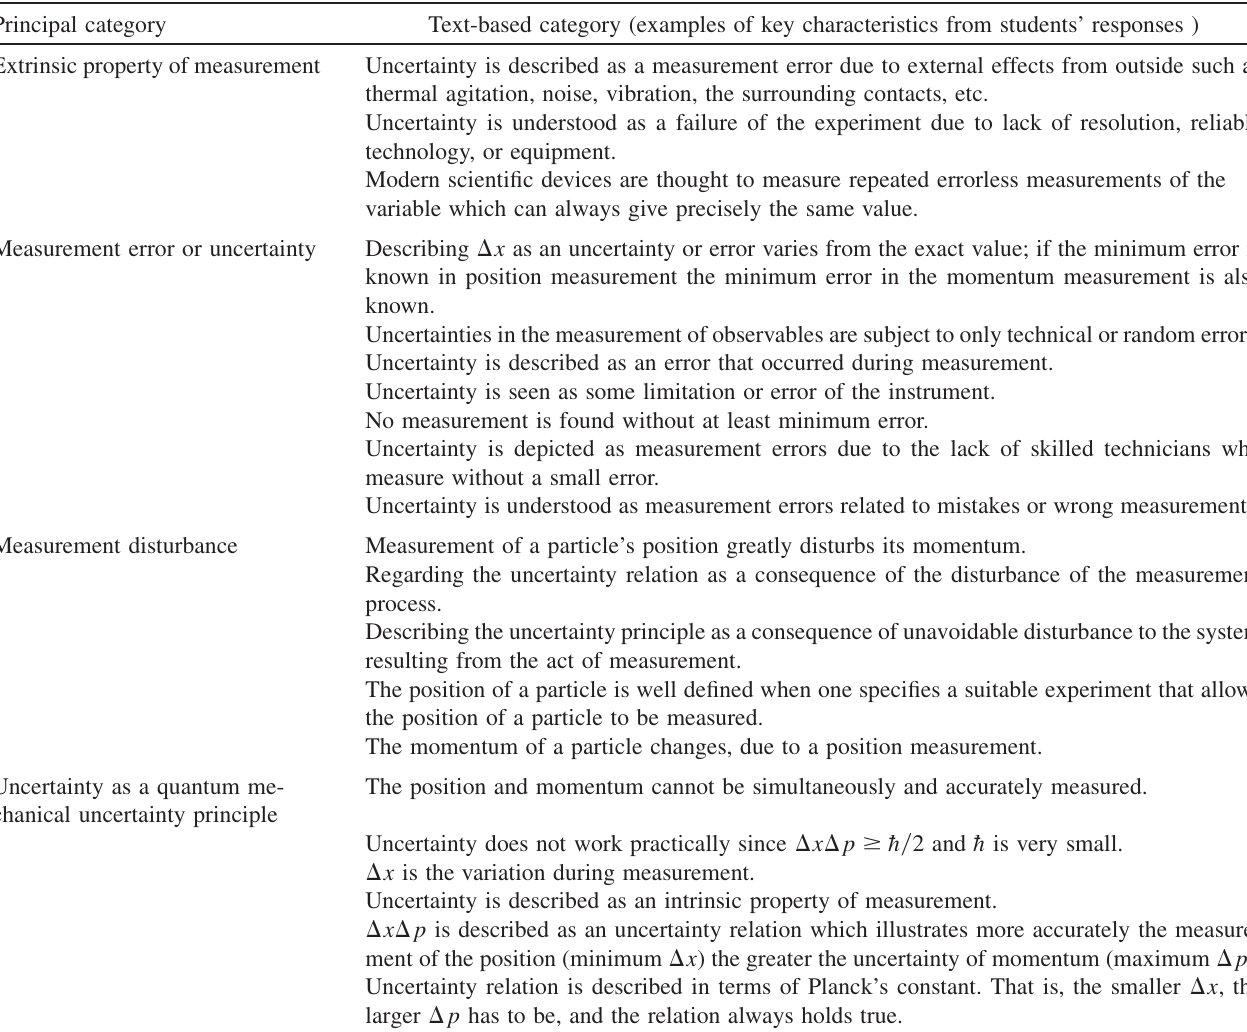
TABLE III. Students’ depiction of concept 2: uncertainty principle. Text-based category (examples of key characteristics from students’ responses